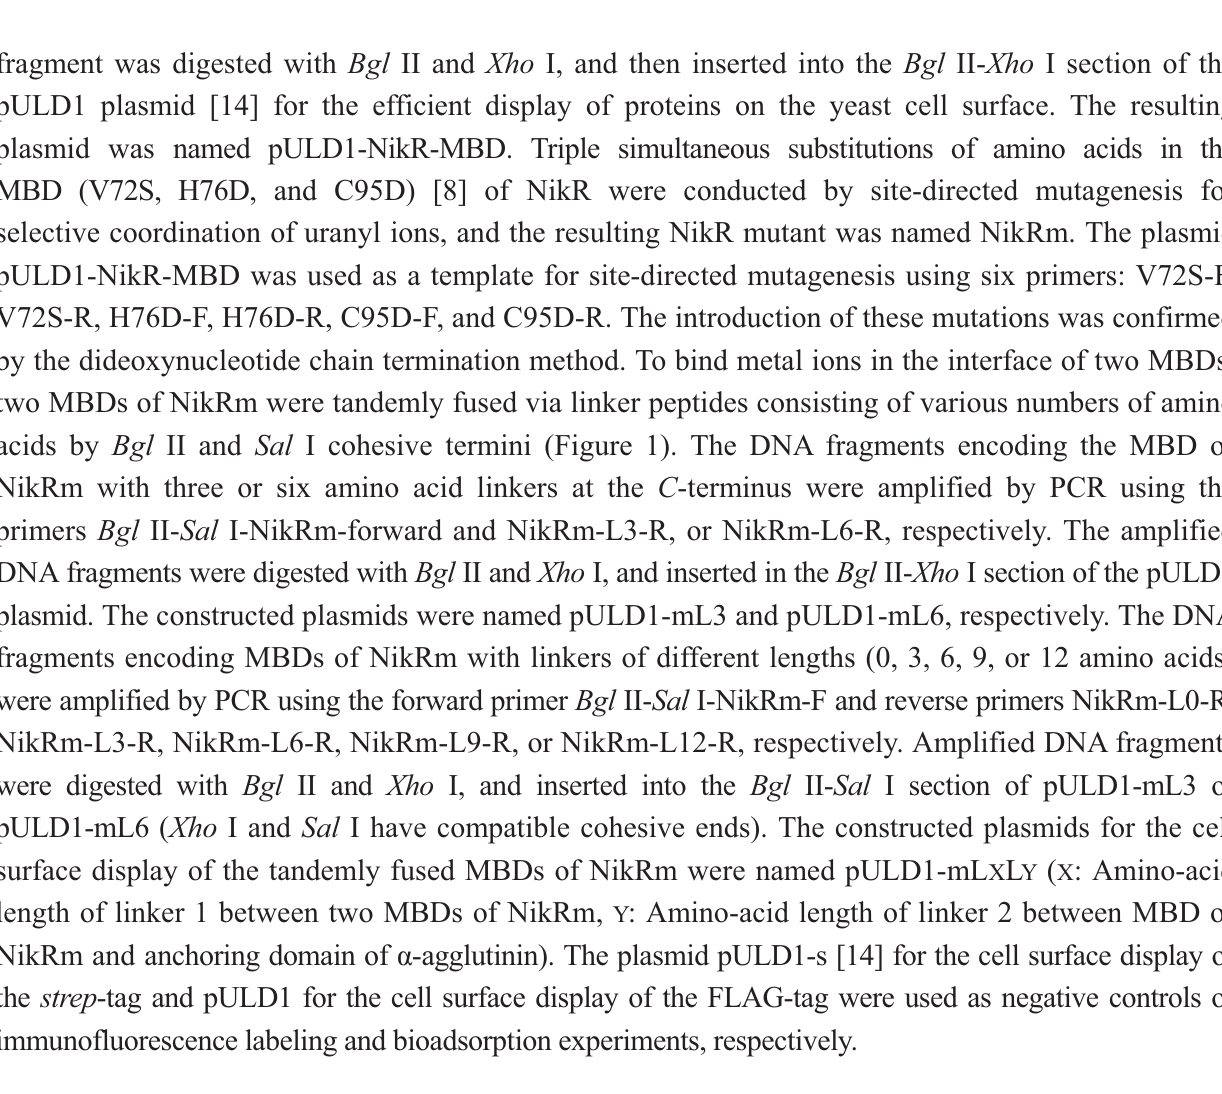
Table 1. Primers used in this